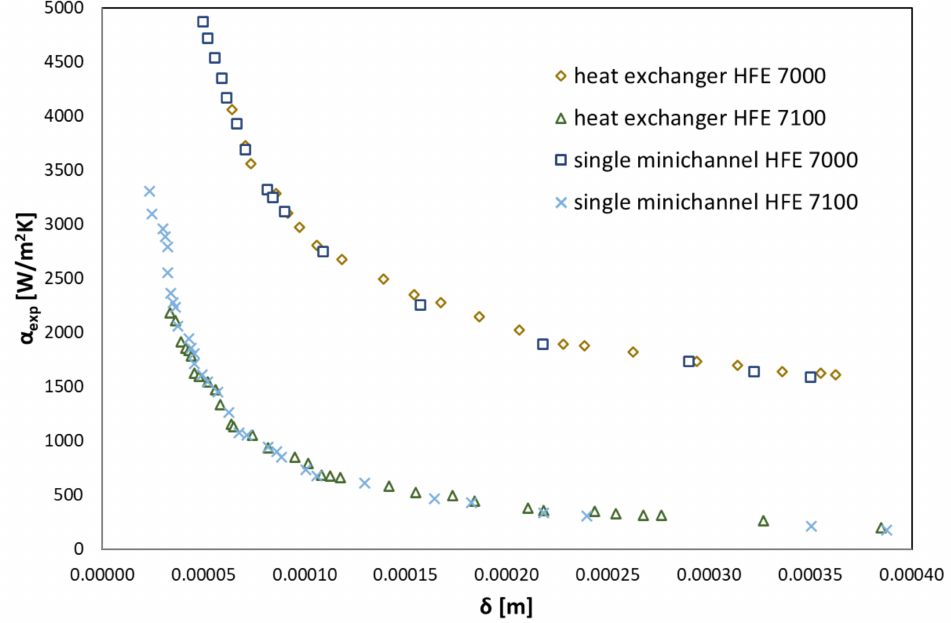
Figure 8. Experimental data of the dependence of the heat transfer coefficient on the condensate thickness of the HFE 7000 and HFE 7100